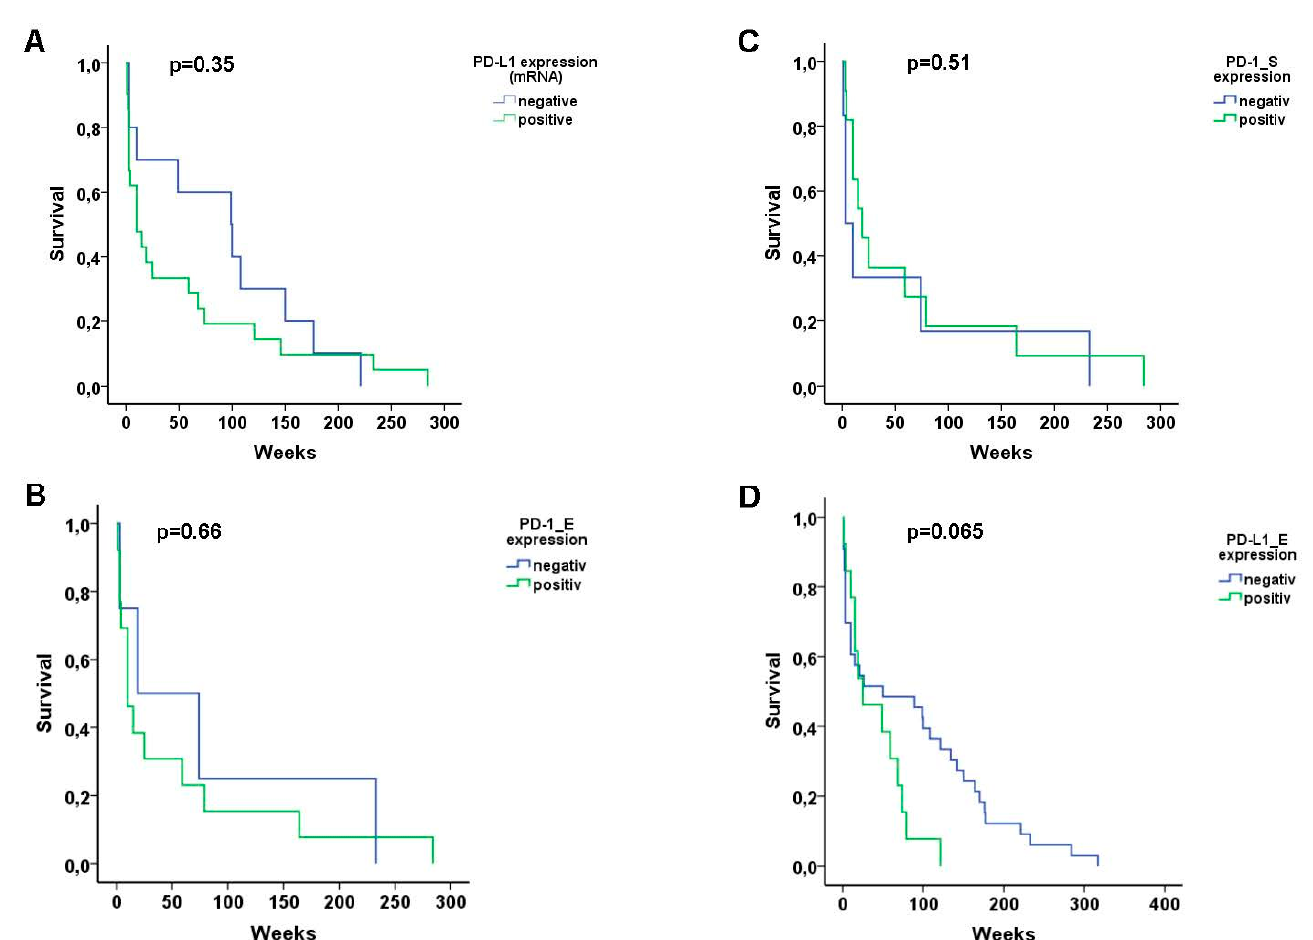
Figure 5. Kaplan–Meier curves for disease-specific survival. No significant difference in survival of the patients was found between ( A ) PD-L1 mRNA positive and negative T-OLP, PD-1 positive or negative T-OLP neither ( B ) in epithelial nor ( C ) in the subepithelial section or ( D ) positive and negative expression of PD-L1 in the epithelia, respectively.